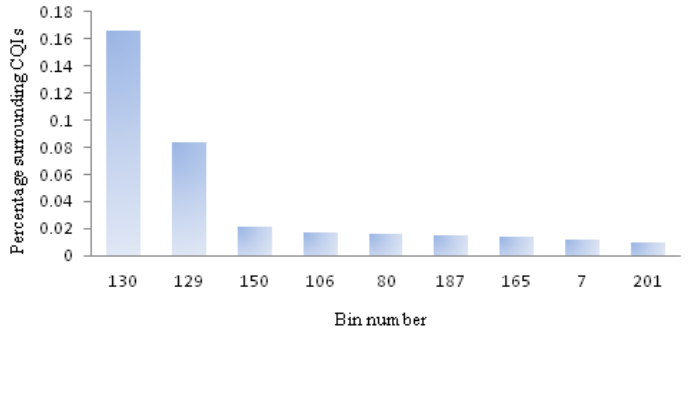
Figure 8. Bin to customer quality incident (CQI)